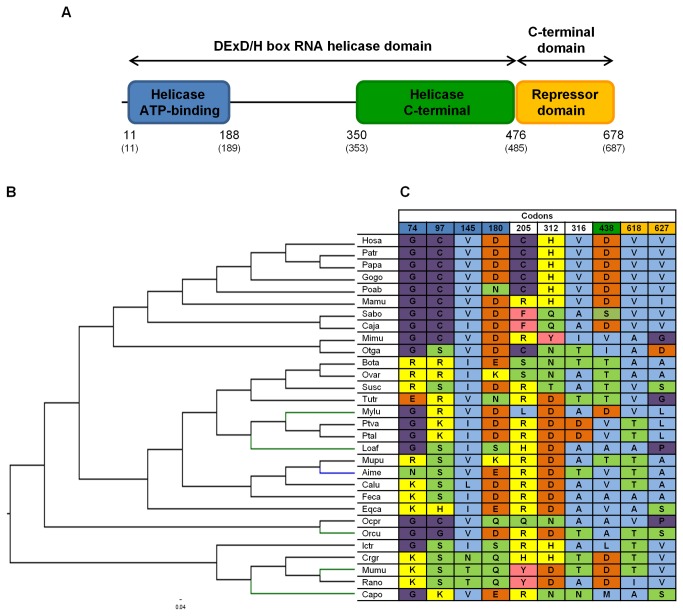
Structural representation and identification of positively-selected branches and codons in mammalian LGP2.(A) Based on human protein structure, the key domains of LGP2 (http://www.uniprot.org/uniprot/Q96C10) and the corresponding boundaries are schematically represented. Also, the human domain boundaries while in the mammalian LGP2 deduced protein sequences alignment (Figure S6) are shown in brackets. (B) Cladogram of 30 mammalian LGP2 genes collected from Ensembl and NCBI databases. Branch-site analyses were performed to identify specific branches under episodic positive selection. Branches with statistically significant likelihood ratio tests (LRTs) when performing PAML branch-site model A (Table 4) are colored in green; branch colored in blue has been simultaneously identified by PAML branch-site model A and Hyphy branch-site REL method (Table 5). (C) Positively-selected codons are exhibited in the table and numbered according to the mammalian LGP2 deduced protein sequences alignment (Figure S6). Colors on the codon numbering row correspond to the LGP2 domain with the same color in the protein structural representation (A). The background colors on the identified codons match different amino acid properties: polar positive (yellow), polar negative (orange), polar neutral (green), non-polar neutral (purple), non-polar aliphatic (blue) and non-polar aromatic (pink). The used abbreviations correspond, by order of appearance, to the following species: Hosa – Human; Patr – Chimpanzee; Papa – Bonobo; Gogo – Gorilla; Poab – Orangutan; Mamu – Rhesus macaque; Sabo – Black-capped squirrel monkey; Caja – Marmoset; Mimu – Mouse lemur; Otga – Bushbaby; Bota – Cow; Ovar – Sheep; Susc – Pig; Tutr – Dolphin; Mylu – Little brown myotis; Ptva – Large flying fox; Ptal – Black flying fox; Loaf – Elephant; Mupu – Ferret; Aime – Giant panda; Calu – Dog; Feca – Cat; Eqca – Horse; Ocpr – American pika; Orcu – European rabbit; Ictr – Squirrel; Crgr – Chinese hamster; Mumu – Mouse; Rano – Rat; Capo – Guinea pig.